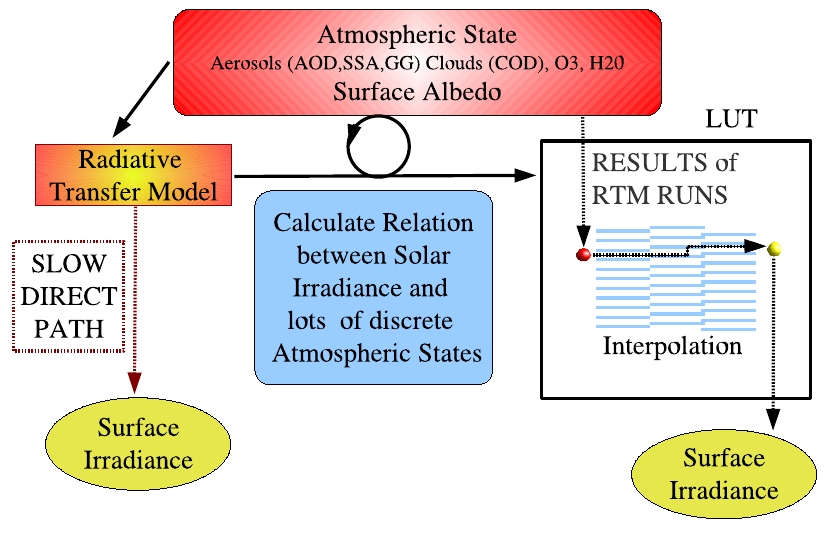
Figure 1. The principle of an LUT approach. The relation of the transmission to a variety of atmospheric states is pre-calculated with a radiative transfer model (RTM) and saved in a look-up table (LUT). Based on the amount of considered atmospheric states the LUT table is large. Usually, 10 5 to 10 7 calculations are needed for a classical LUT approach if specific scientific optimizations are not applied. This figure has been previously published in